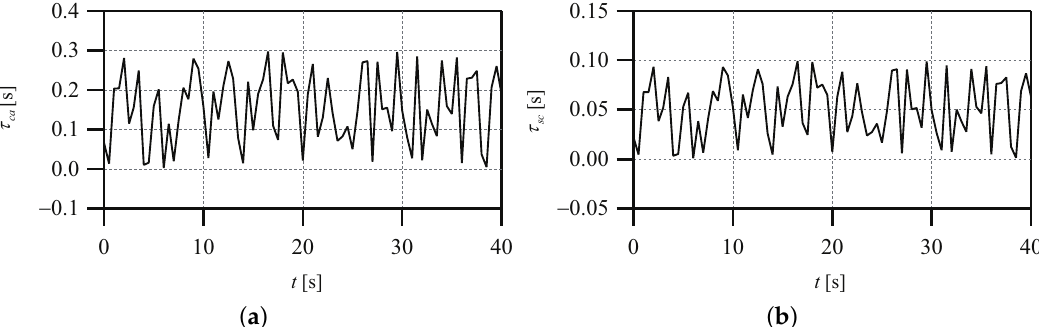
Figure 2. Random delays in the IEID-based NCS. ( a ) Time delay from the main controller to the actuator; ( b ) Time delay from the sensor to the main